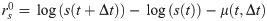
Time evolution of nodes’ strengths.The strength si of node i is the number of emails that user i exchanged with other users during one year. (A) Distributions of strengths for each one of the years in our dataset (2007-2010). Note that the distribution is stable in time. (B) Distribution of centered strength logarithmic growth rates rs0=log(s(t+Δt))-log(s(t))-μ(t,Δt) for Δt = 1, 2, 3 years (dots, squares and diamonds, respectively). Lines show fits to a Laplace distribution (parameters Δt = 1: σexp = 0.57, Δt = 2: σexp = 0.74 and Δt = 3: σexp = 0.83). Note that as Δt increases the distributions are wider (see Fig D in S2 File). For the specific values of the distribution modes μ(t, Δt) see Fig B in S2 File.